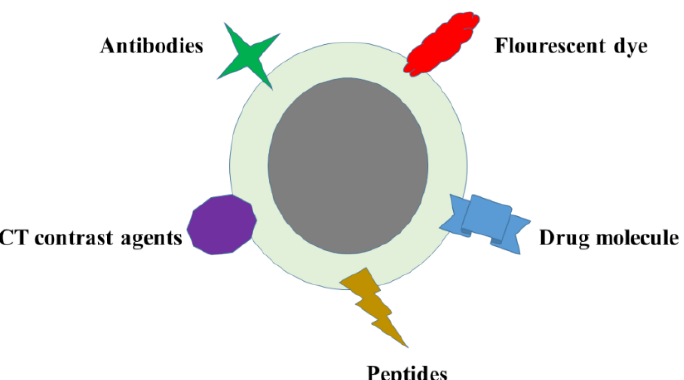
Figure 1. Schematic representation of functionalized MNP. The surface of MNP can be functionalized by the insertion of specific molecules, such as antibodies, peptides, drugs, fluorescent dye, and/or contrast agents for computerized tomography.